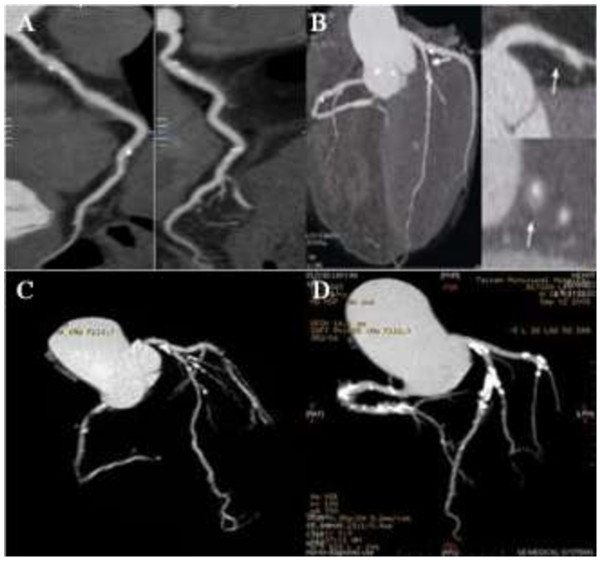
320-slice CT scans show the typical variable degree of CAC images among diabetic patients. (A): mild calcification, CACS = 89; (B): moderate calcification, CACS = 374; (C): severe calcification, CACS = 525; (D): extensive calcification, CACS = 1986.